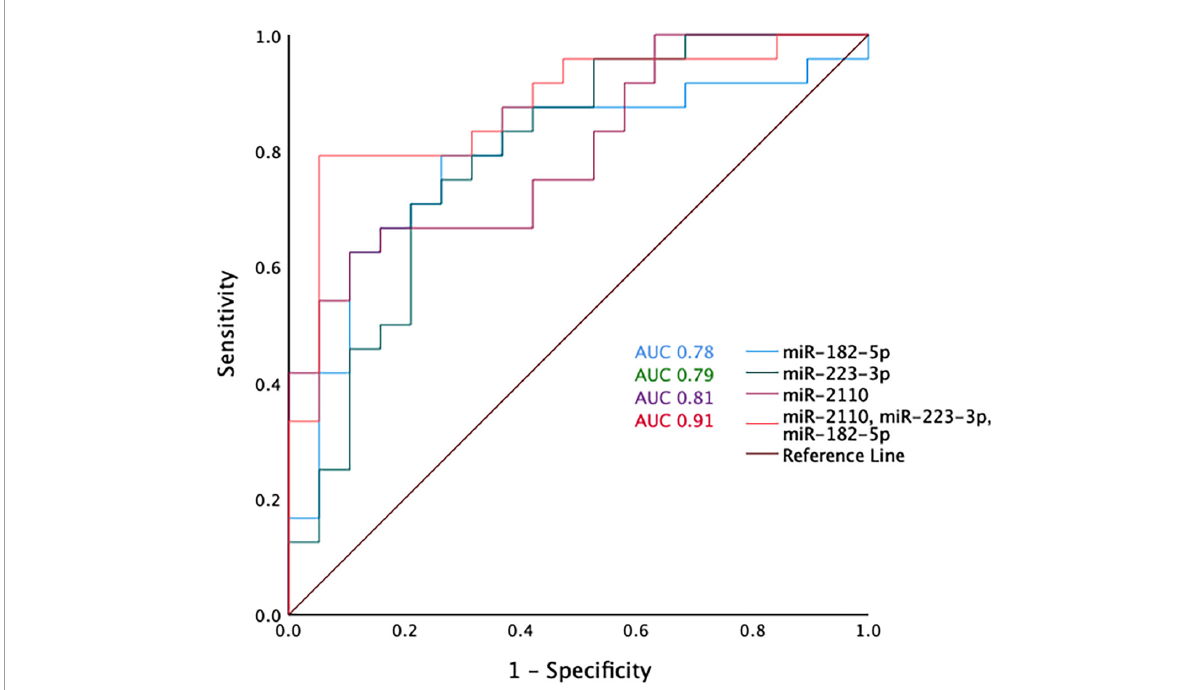
FIGURE3 Receiver operator curve analysis for miR-2110, miR-223-3p, and miR-182-5p and the combination of miR-2110, miR-223-3p, and miR-182-5p.